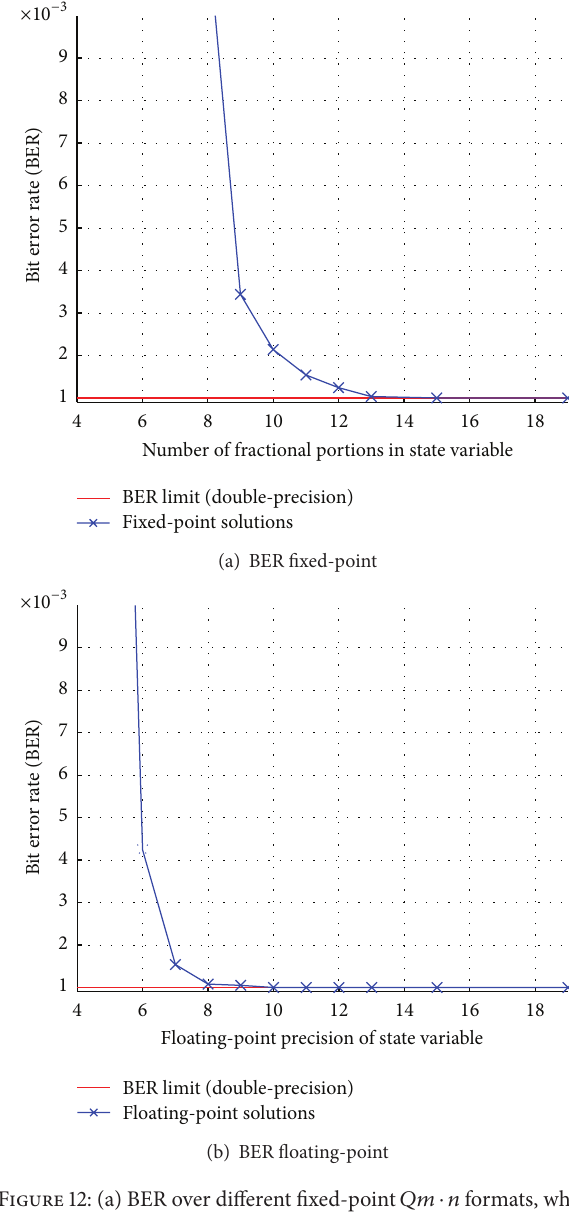
Figure 12: (a) BER over different fixed-point 𝑄𝑚 ⋅ 𝑛 formats, where 𝑚 is constantly set to 8 and 𝑛 is the number of fractional bits. (b) BER over different floating-point precisions, where the exponent is limited to the range of ±